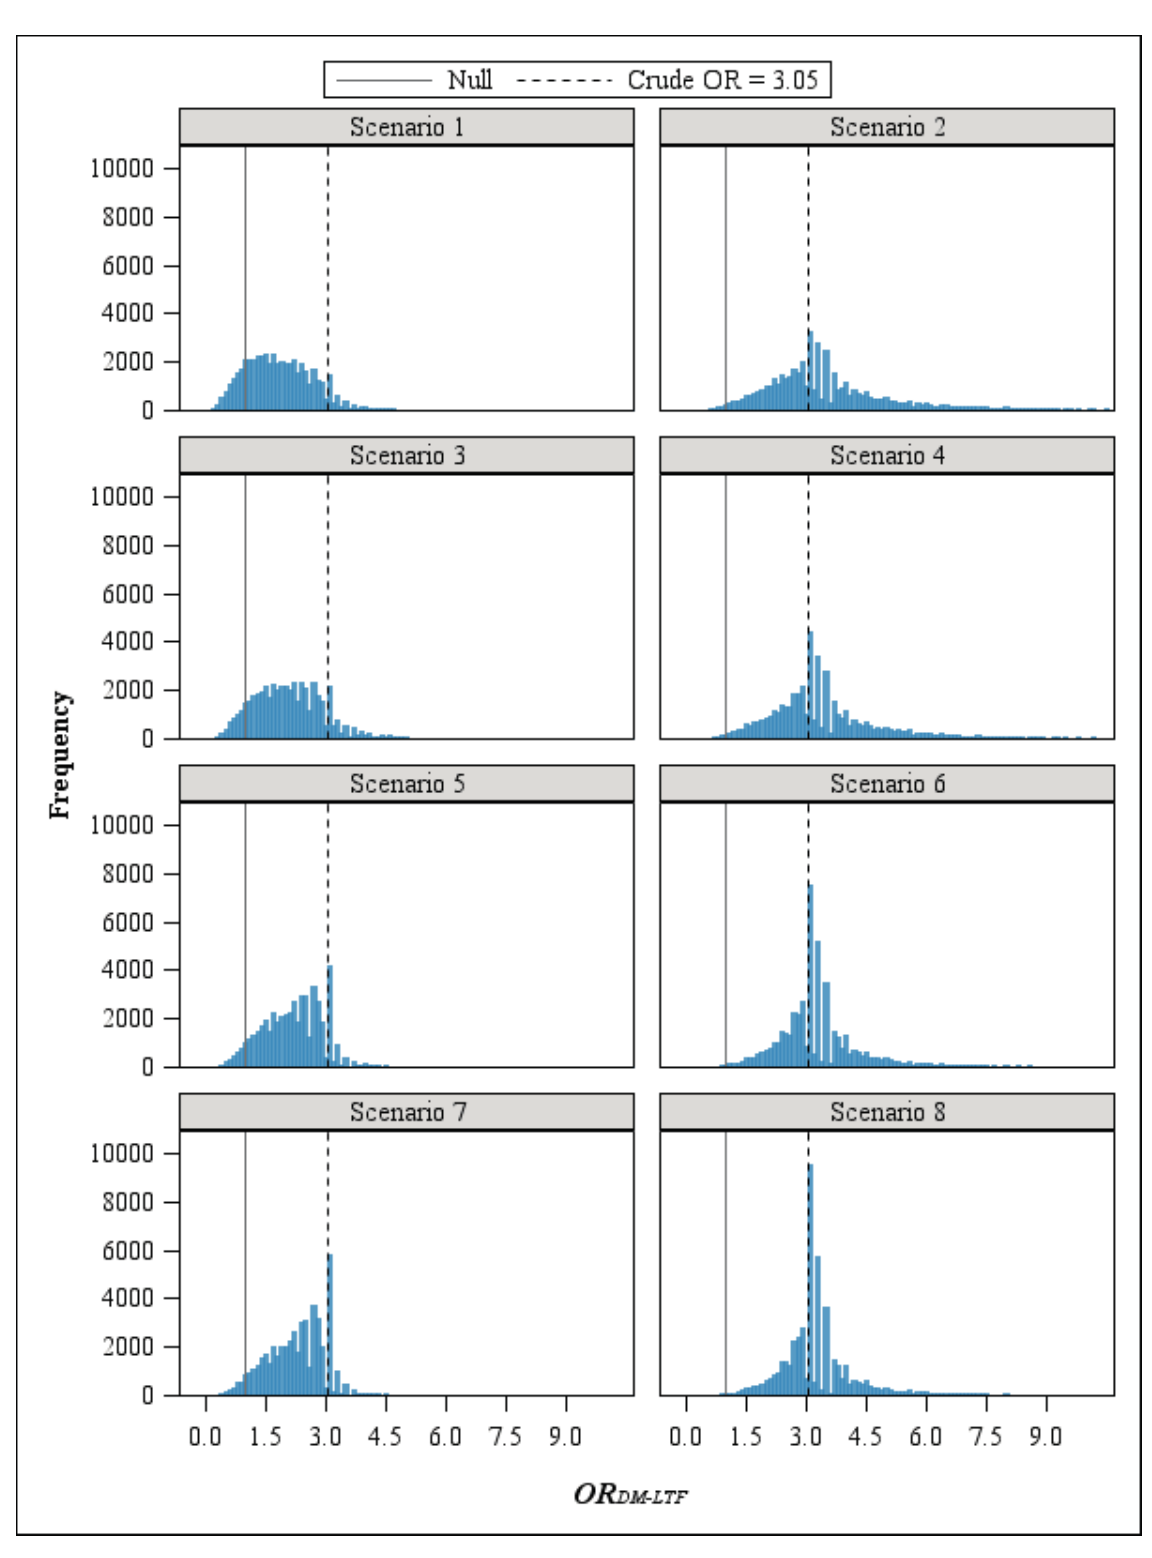
Figure 4. Frequency distributions of OR